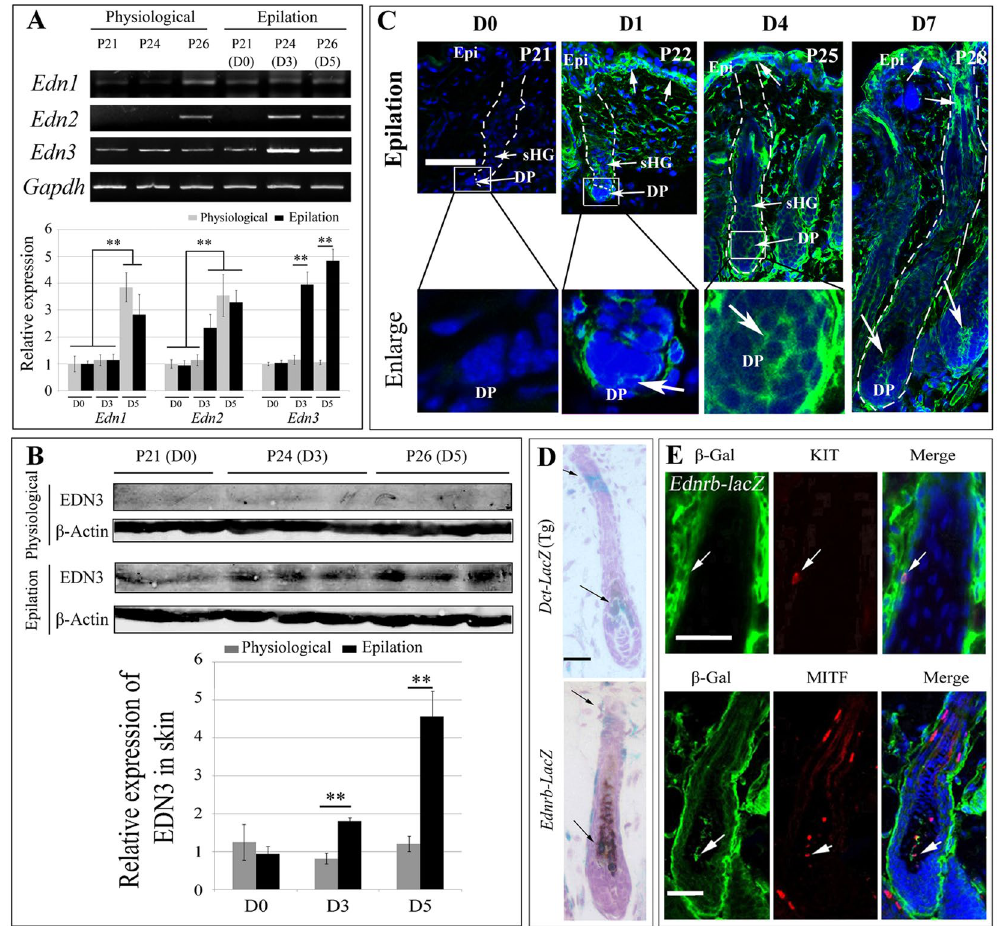
Figure 3. Epilation induces expression of endothelin-3 (Edn3) in C57BL/6 J mice. ( A ) RT-PCR and qRT-PCR analysis for Edns expression changes in skin after epilation. Mice were epilated at P21 and gene expression was analyzed at the indicated days. Full-length gels are shown in Fig. S11. ( B ) Western blotting analysis for protein expression of EDN3 in the skin. Full-length gels are shown in Fig. S12. ( C ) Immunofluorescence of EDN3 on scalp skin at 0, 1, 4, and 7 days after epilation. Arrows indicate EDN3 + cells in the hair follicles. ( D ) X-gal staining of hair follicles from Dct -lacZ transgenic mice (upper panels) and Ednrb lacZ / + mice (lower panels). Arrows indicate the lacZ + cells in the hair bulges and bulbs. ( E ) Immunohistochemistry of β - Gal, KIT, and MITF in pigmented hair follicles from postnatal day 7 Ednrb lacZ / + mice. Arrows indicate KIT and β - Gal co- labeled cells in the bulge (upper panels) and MITF and β - Gal co-labeled cells in the hair bulb (lower panels). Epi, epidermis; DP, dermal papilla; sHG, secondary hair germ. Bar: 50 μ m. ** Indicates p < EDNRB affects McSC proliferation in hair follicles and regulates melanogenesis-related gene expression. To examine how the lack of Ednrb decreases skin pigmentation, we histologically analyzed the pigmentation of hair follicles on the scalp (which, as mentioned, remains pigmented in Ednrb − / − mice in con- trast to the back). As shown in Fig. 5A, on day 5 after epilation, hair bulbs and hair shafts of Ednrb − / − mice were normally present in the scalp but were hypopigmented compared with those of wildtype mice, suggesting that loss of EDNRB does not affect the hair cycle but decreases melanocyte numbers or melanin synthesis in the bulb. Indeed, 7 days after epilation, the melanosome number of Ednrb − / − mice was much lower than that of wild- type mice (Fig. 5B). In addition, melanocyte-specific markers such as PMEL17 and TYR could not be detected in the dermis, orifices of hair follicles, or the interfollicular epidermis of Ednrb − / − mice 5 days after epilation, even though they were present at low levels in hair bulbs (Fig. S7C). Furthermore, the McSC marker KIT and pigmented melanocytes remained undetectable even 7 days after epilation (Fig. 5C and Fig. S7D). These results suggested that EDNRB is required for epilation-induced epidermal melanocyte regeneration. To analyze how the loss of EDNRB decreases the melanin level of hair bulbs, we then quantified melanocyte numbers in each hair bulb of wildtype and Ednrb − / − mice 7 days after epilation. The number of MITF-positive cells upon epilation was lower in each hair follicle of Ednrb − / − mice (11.7 ± 2.2) compared to hair follicles in wildtype mice (15.7 ± 1.43) (Fig. S7D). This result suggested that loss of EDNRB could block epilation-induced proliferation of melanocyte lineage cells. Recently, Takeo et al . found that during physiological hair regeneration, EDNRB signaling is also required for McSCs proliferation and maintenance 29 . Nevertheless, whether EDNRB affects